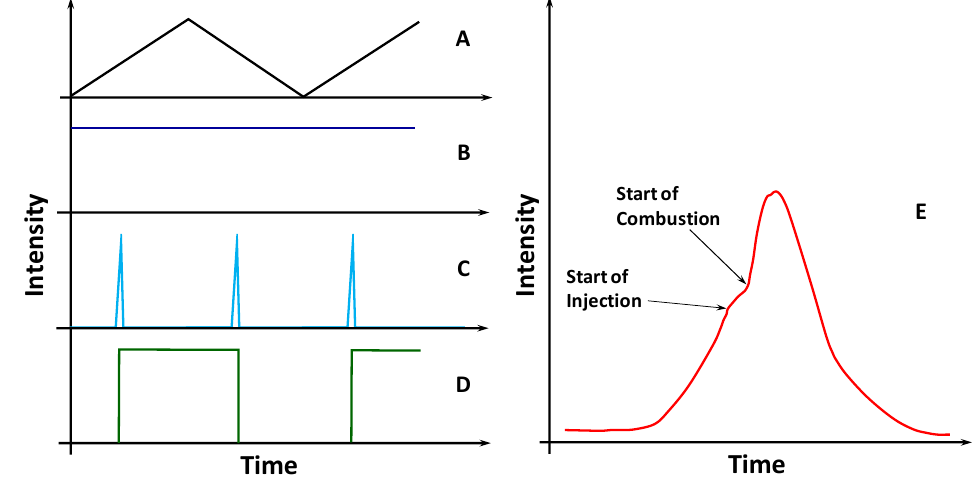
Figure 2. The letters from A to E represent points with signals waveforms from the sweep laser to the demodulator output. In this figure, the signal in E shows a typical engine combustion cycle.